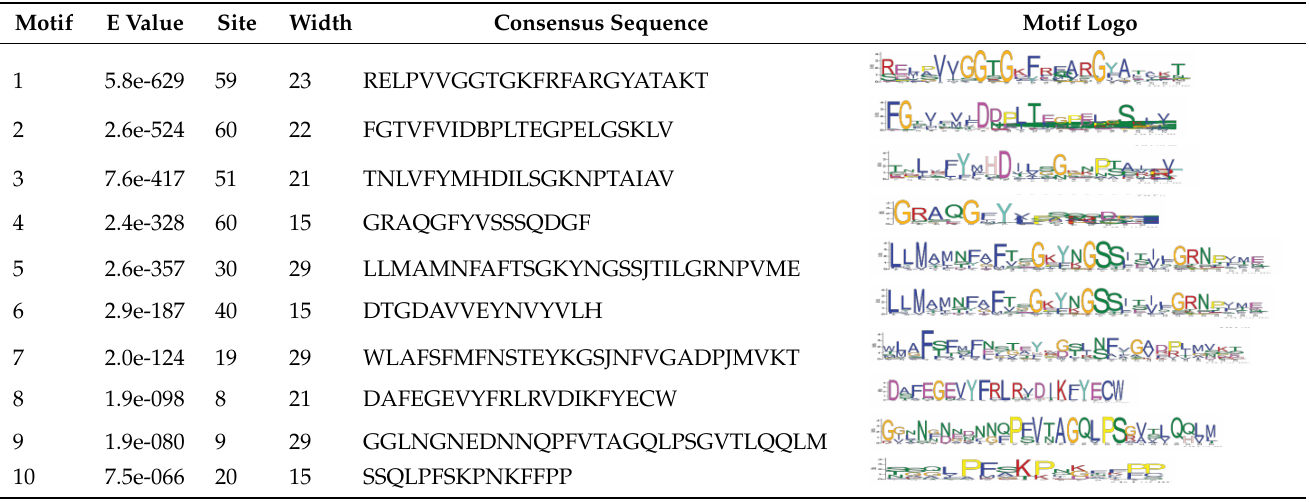
Table 2. Identified motif of ClDIR, CmDIR and CsDIR genes. Logo chart of the conserved motifs, sequence, site, width and E values were obtained from MEME (Multiple Em for Motif